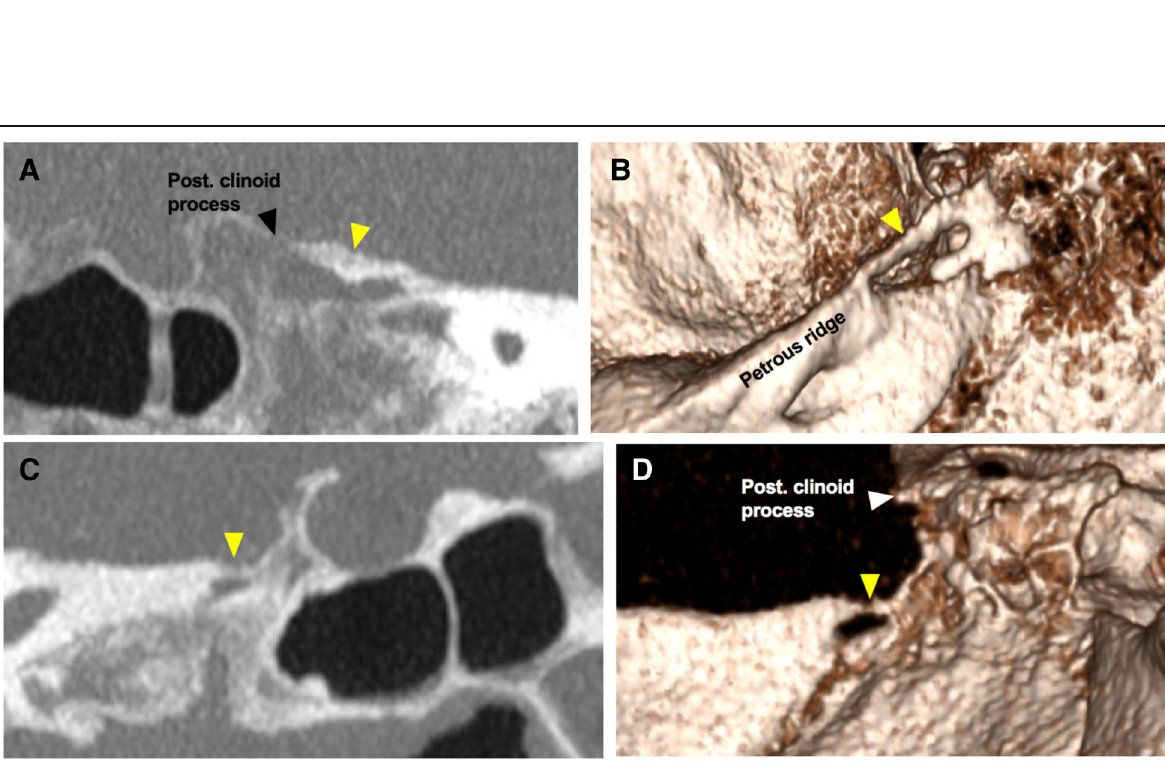
Fig. 2 Mineralised posterior petroclinoid and petrosphenoid ligaments. a Oblique-sagittal maximum-intensity projection (MIP). b 3D volume reconstruction of a right-sided, completely mineralised posterior petroclinoid ligament (or dural fold) (yellow arrowhead). c Oblique-sagittal maximum-intensity projection (MIP). d 3D volume reconstruction of a right-sided, complete petrosphenoid bar (yellow